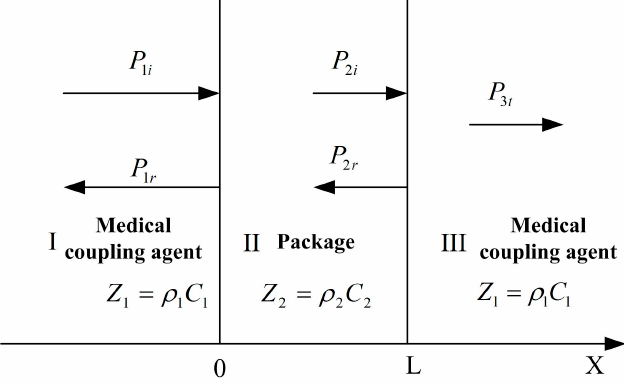
Figure 11. Theoretical model of the three-layer medium.